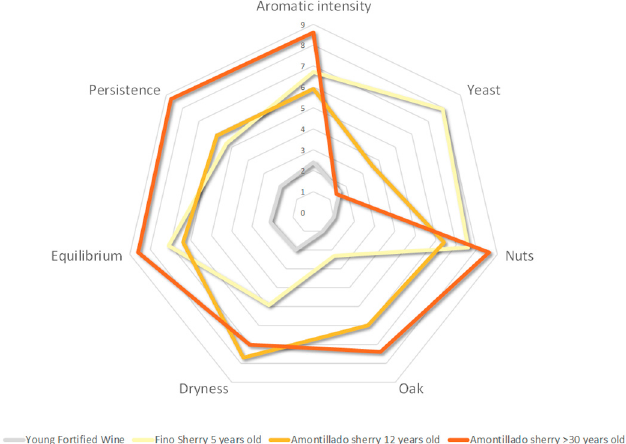
Figure 4. Spider graph of the average scores of the tasting panel for the wines evaluated.